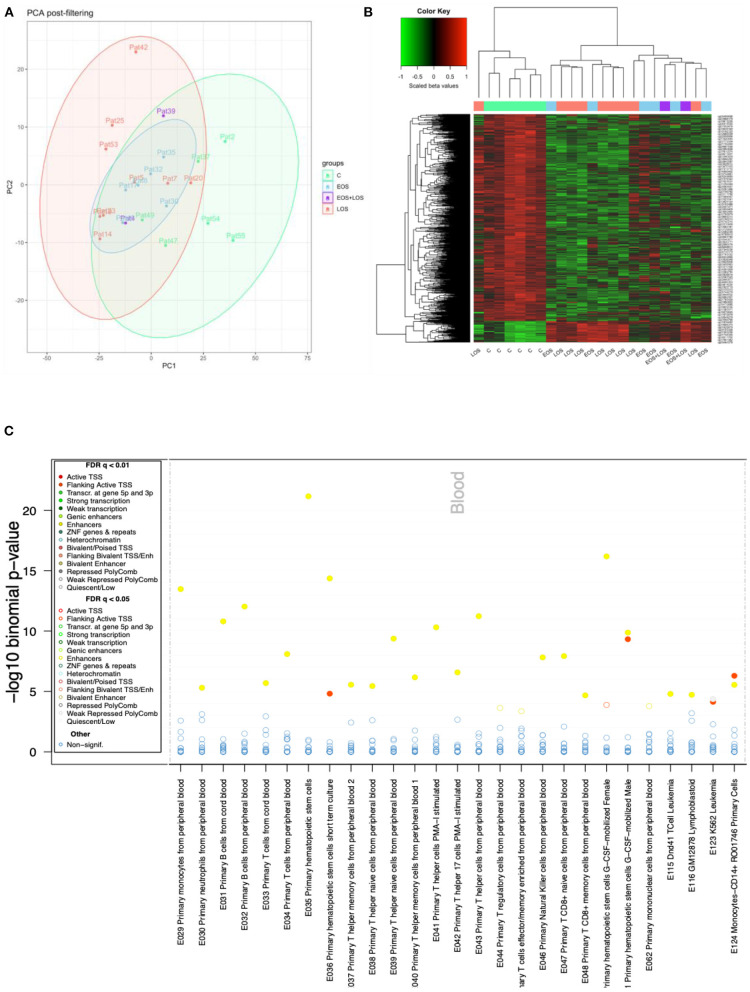
DNAm analysis. (A) Principal component analysis (PCA) of methylation data of control (light green), LOS (pink), EOS (light blue), and EOS plus LOS (purple) samples. (B) DNAm heatmap showing the significant top 1,000 differentially methylated CpGs between controls and neonates with sepsis, obtained with limma. The methylation metric used to obtain the heatmap is the beta values scaled by the median, shown at the top left color scale (where red represents higher methylation levels, and green lower methylation levels). This displays the clustering of sepsis samples separated from control samples with the exception of one LOS sample. (C) eFORGE analysis. Enrichment analysis of regulatory element classes in different blood cell types for the top 1,000 CpG sites between septic neonates and control neonates. Cell types are shown on the horizontal axis and the significance (–log10 binomial p-values) is shown on the vertical axis. Each dot represents an enrichment q-value for a given cell type, colored according to the enriched regulatory element class, as shown in the legend (where yellow points correspond to enhancers and red points correspond to transcription start sites).